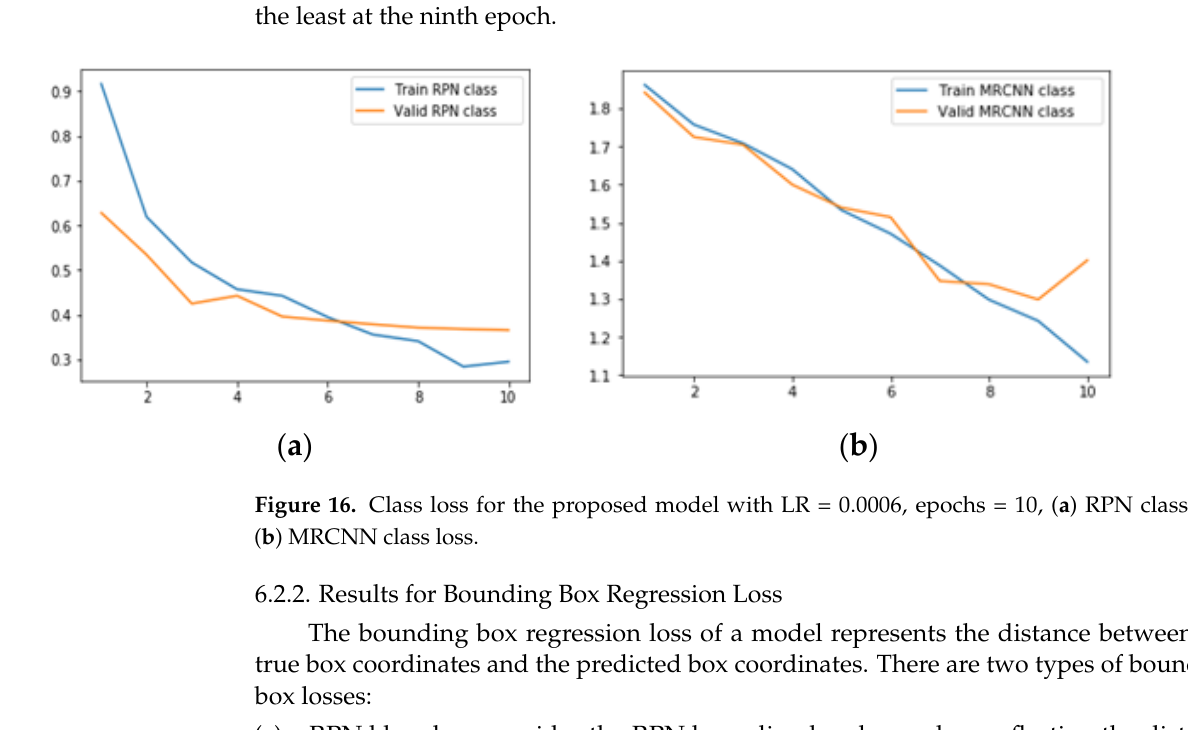
(3) Here, λ represents the balancing parameter set to 10. N bo x is the normalization term equal to the number of anchor locations, set to 256. P i represents the predicted probability that anchor i is an object. P i * L 1 shows that regression loss is active for positive anchors ( P i * = 1) only. t i represents the predicted four coordinates. t i * represents ground truth coordinates.